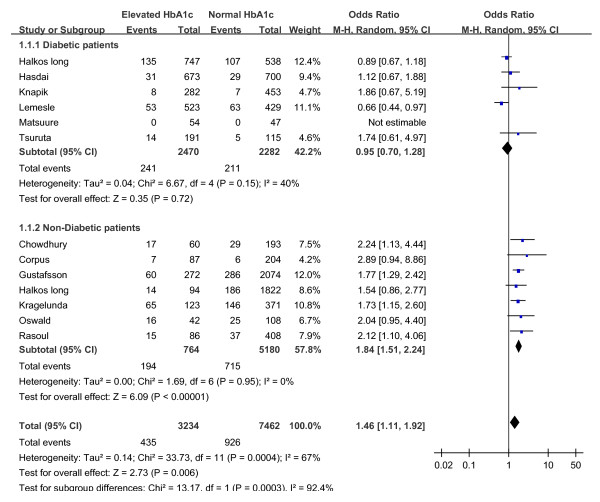
Unadjusted risk of mortality for patients with or without diabetes based on elevated or normal HbA1c level.